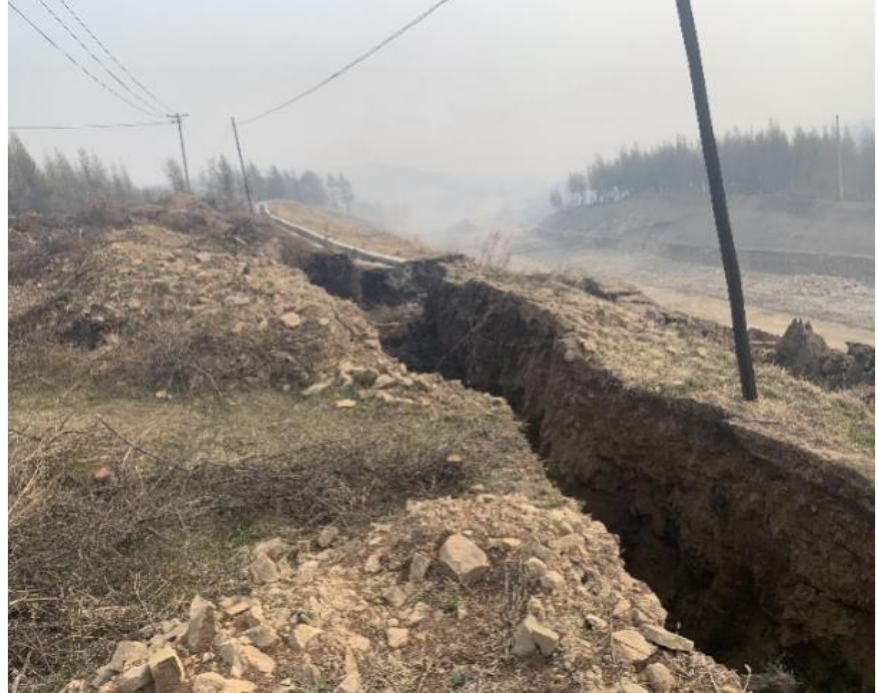
Figure 8. Top view of the instability and collapsed top of a slope containing a coal seam in a goaf.